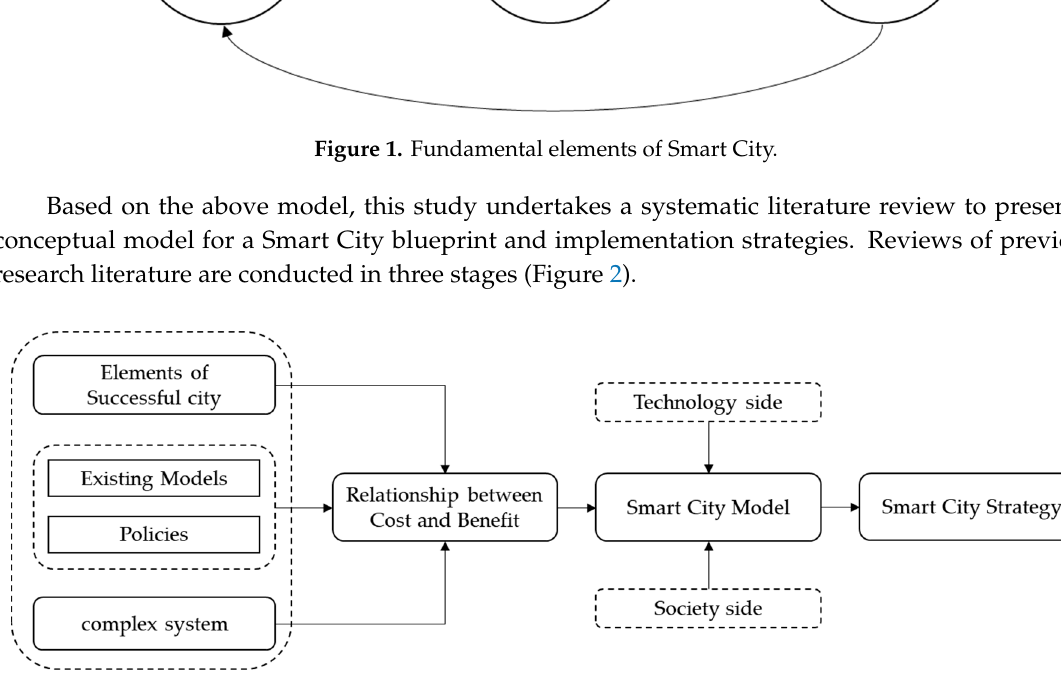
Figure 1. Fundamental elements of Smart City.